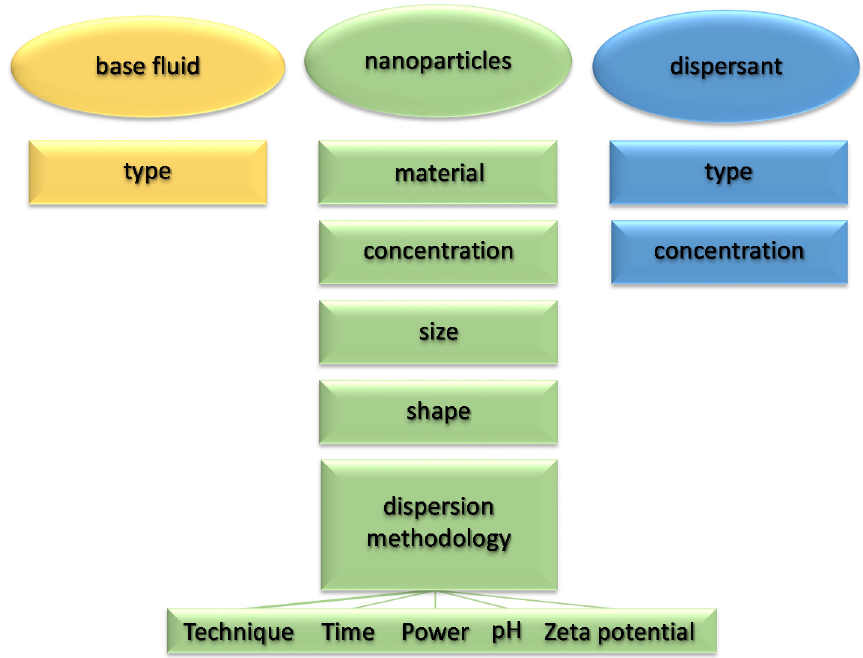
Figure 1. Main parameters affecting the thermophysical properties of nanofluids.